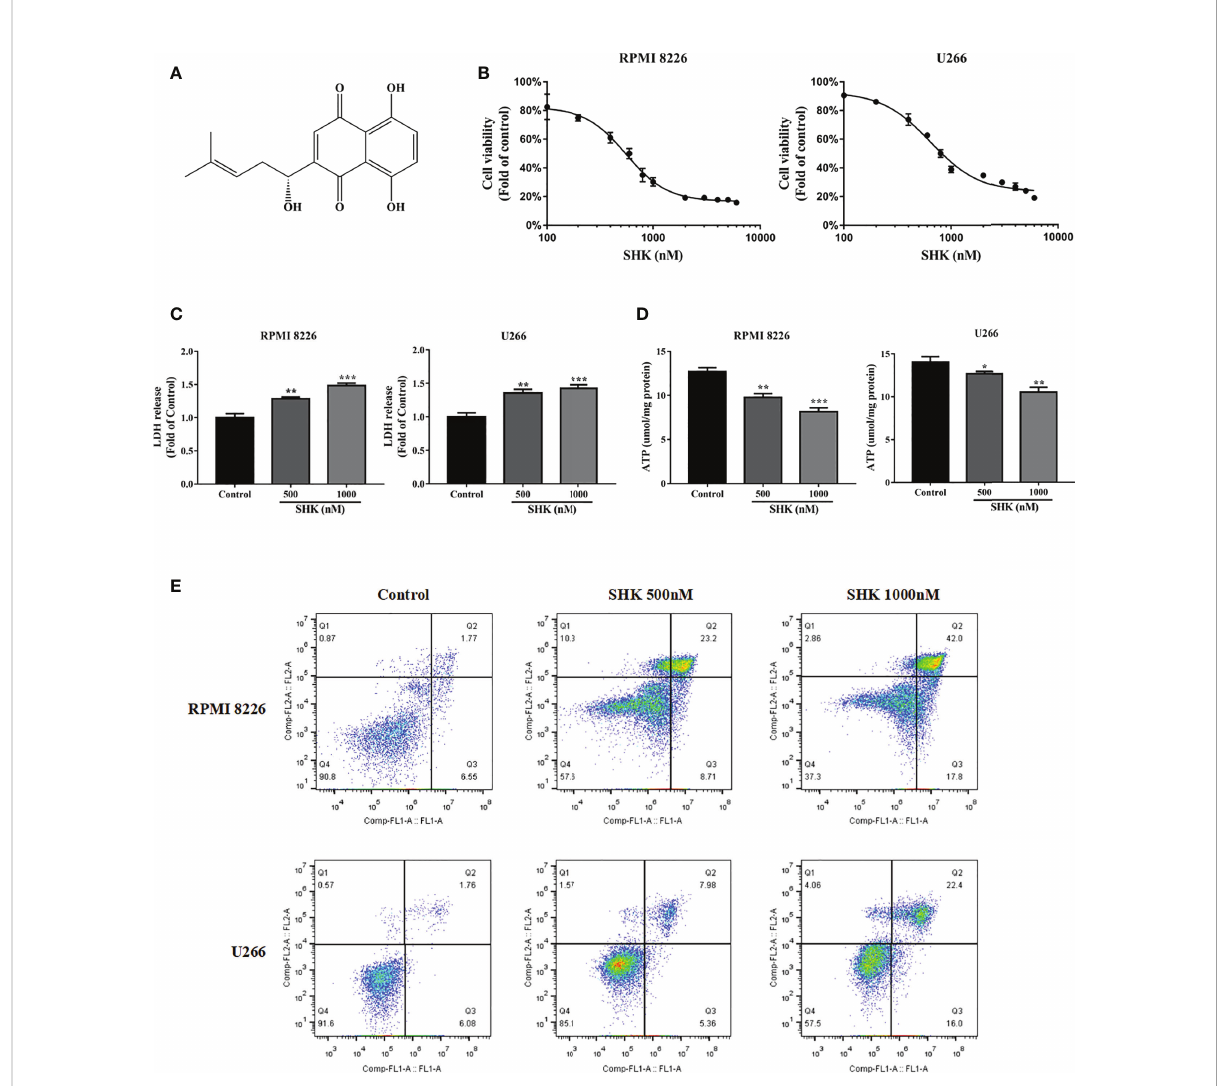
FIGURE 1 SHK has anti-myeloma effects. (A) The chemical structure of SHK. (B) MTT to test the inhibitory effect of SHK on MM cell proliferation. (C) LDH release levels in MM cells treated with SHK. (D) ATP levels in MM cells treated with SHK. (E) MM cells were incubated with SHK or vehicle for 24 h, then stained with annexin V-FITC/PI and analyzed by fl ow cytometry. Data are presented as the mean ± SD. * p < 0.05, ** p < 0.01, *** p <